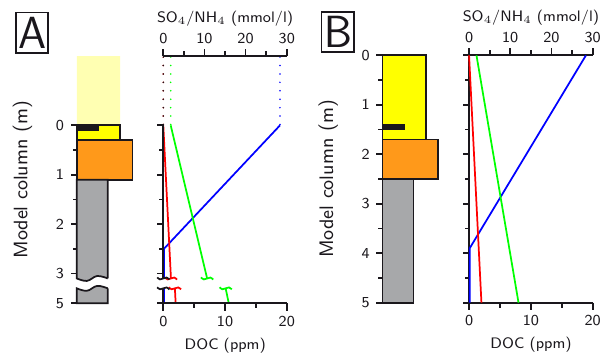
Fig. 5. Model setups of (A) scenario A and (B) scenario B (cf. Fig. 4). Initial pore water profiles of DOC ( green ), SO 4 ( blue ), and NH 4 ( red ). Respective POM and SPOM priming positions are shown in black . Corresponding to facies (cf. Fig. 2), variable sedi- ment diffusivities are assumed: φ = 0 . 5, θ = 2 . 4 ( yellow ); φ = 0 . 6, θ = 4 . 4 ( orange ); φ = 0 . 7, θ = 9 . 4 ( gray